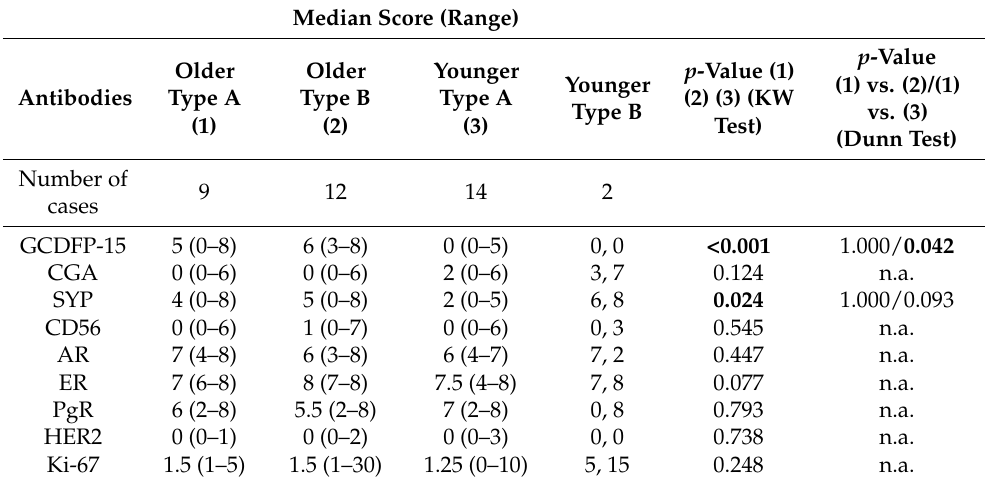
Table 4. Immunohistochemical features of breast mucinous carcinomas among four subgroups.